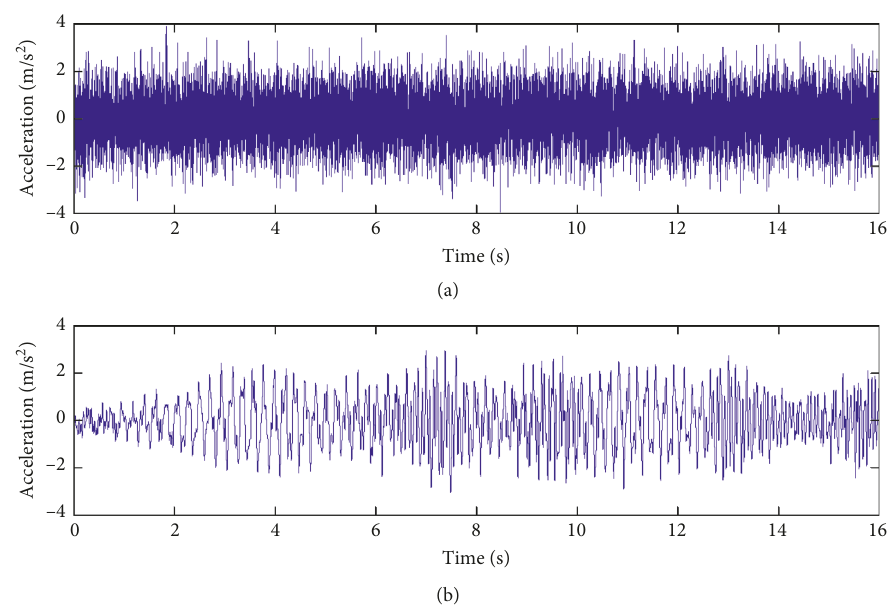
Figure 5: Support excitation and acceleration response of m of m 1